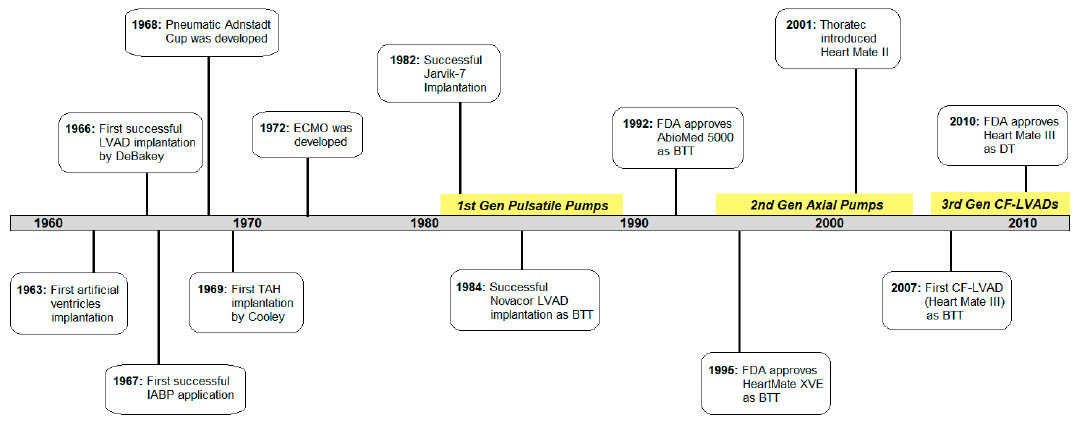
Figure 2. Timeline of important milestones of cardiac assist device (CAD) development history [38,39].